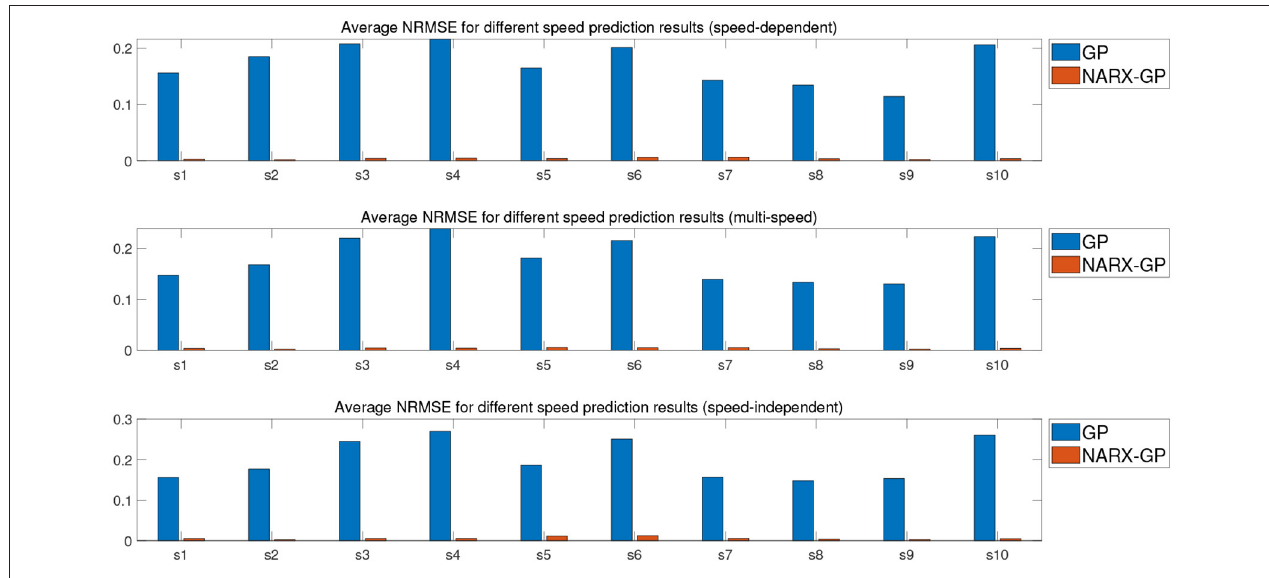
FIGURE 9 | Average NRMSE for prediction of joint angle under different speed.